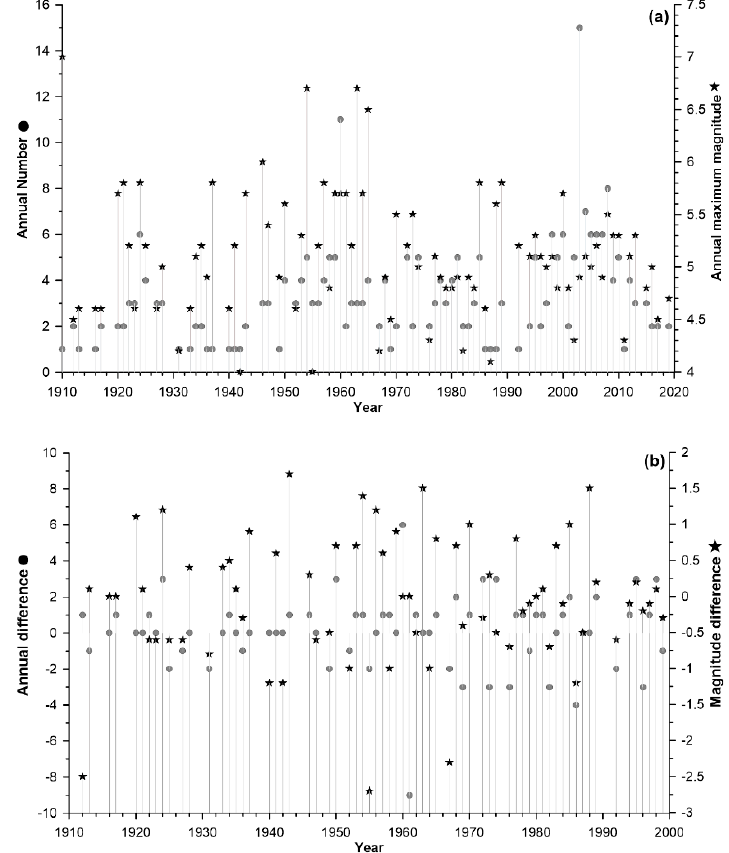
Figure 3. ( a ) Annual number of earthquakes (circles) and maximum annual magnitude (stars) in the period 1910–2019. ( b ) Differential time series for annual earthquake number (circles) and for maximum annual magnitude (stars) in the period 1910–2000. Table 1. Annual earthquake number and annual maximum magnitude time series stationarity (ADF) and normality (SW) tests results. ARIMA model selection using the AIC and BIC criterions are also showed.